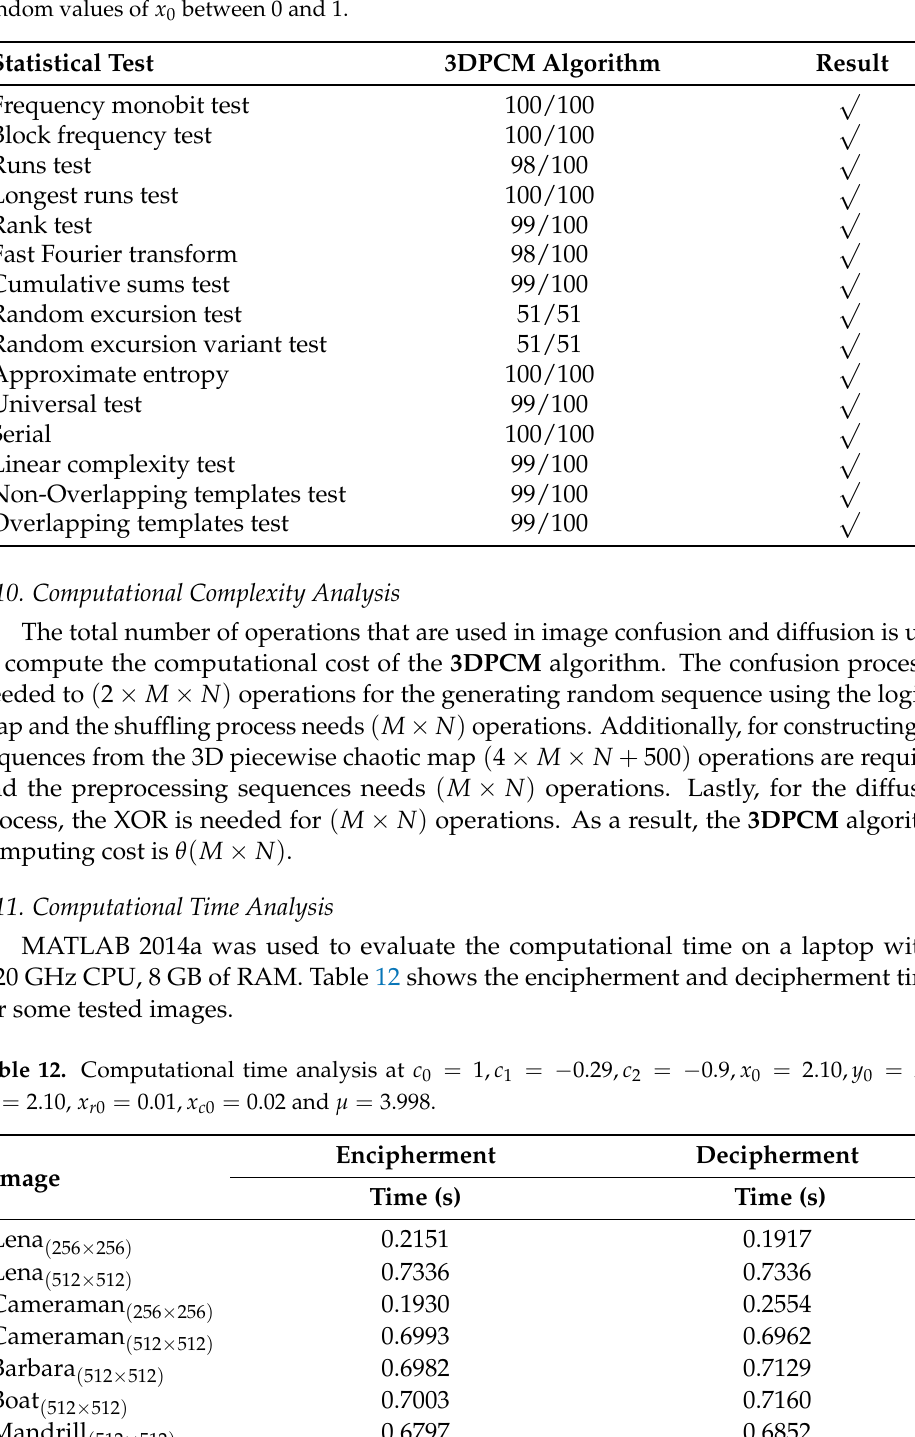
Table 12. Computational time analysis at c 0 = 1, c 1 =